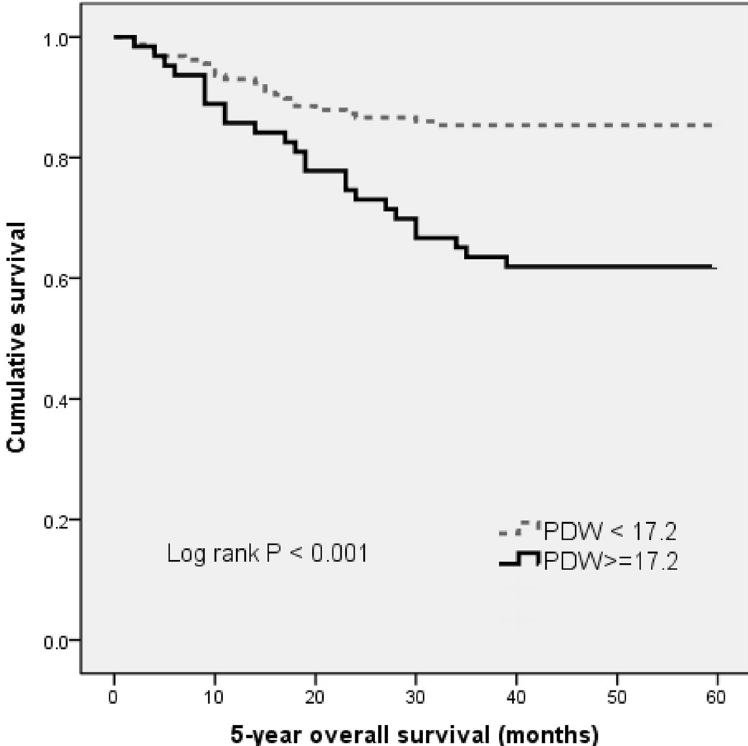
Figure 2. Kaplan–Meier analysis of overall survival in melanoma